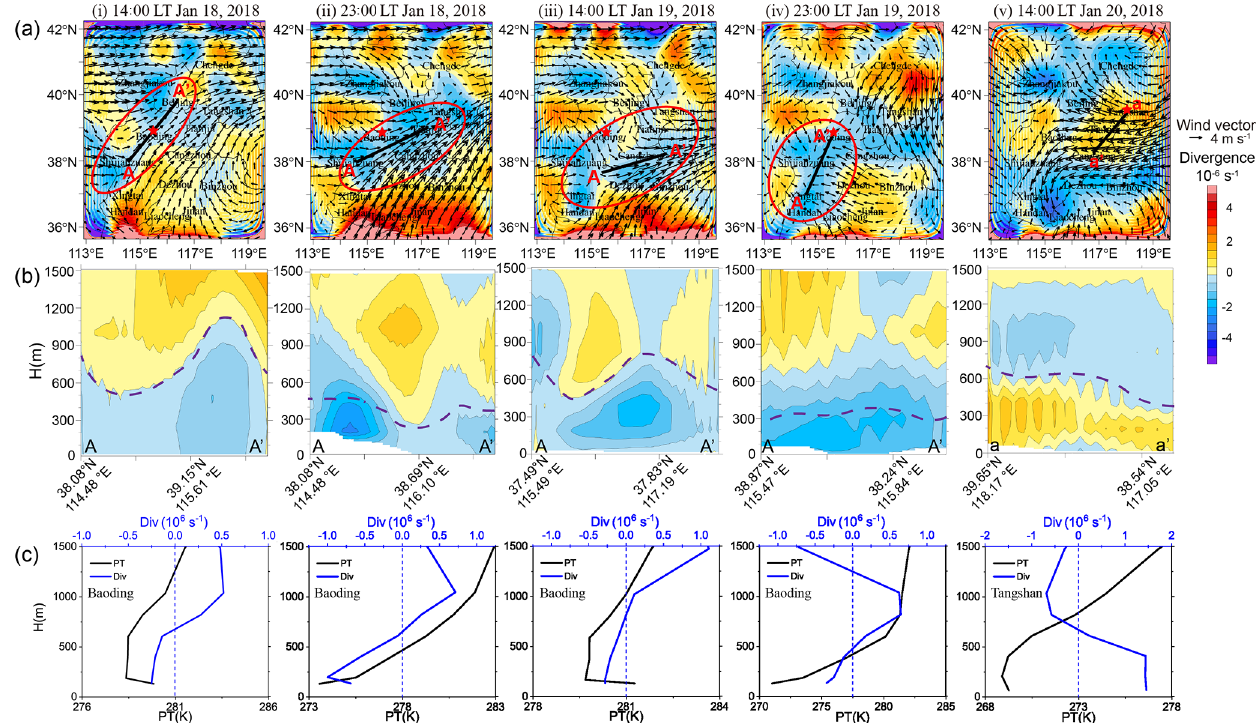
Figure 8. (a) Surface spatial distributions, (b) vertical cross sections and (c) vertical profiles of the simulated wind divergence at the pollution stages of (i) formation, (ii–iv) maintenance, and (v) diffusion during representative case 1 under west–southwest wind shear mode. The red ellipses, black lines, and red stars in (a) indicate the convergence belt, the section lines in (b) , and the profile sites in (c) , respectively. The dashed purple lines in (b) indicate the PBL heights. The potential temperature profiles are presented in (c) to indicate the boundary layer top at the representative